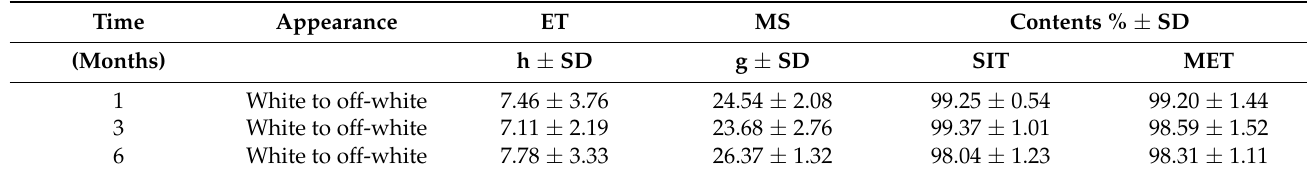
Table 5. Stability study of the optimized formulation R4.